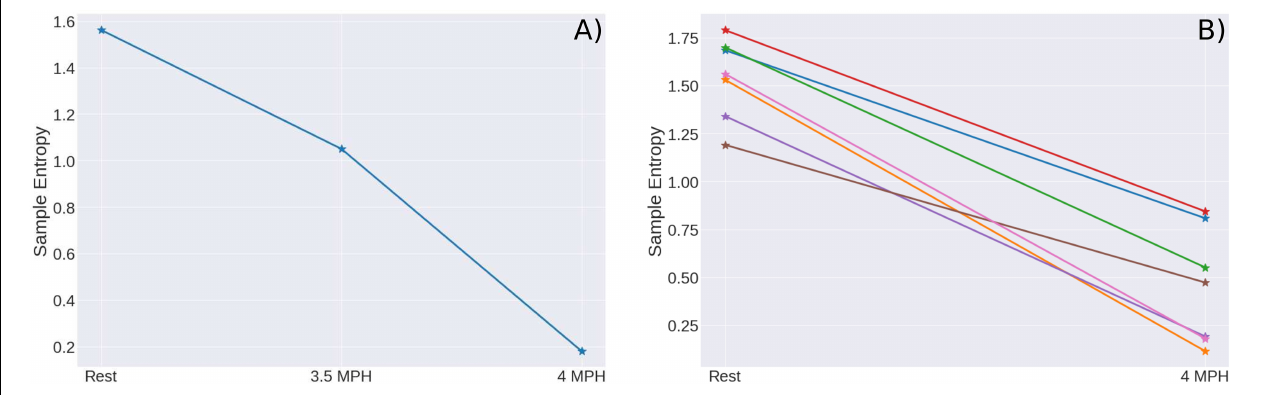
FIGURE 4 | (A) SampEn for one subject where the first record belongs to the rest period, the second record to a cardiac stress condition at 3.5 mph and the third measure to a cardiac stress condition at 4 mph. (B) SampEn values for rest and cardiac stress tests of one subject in seven measures. The mean of SampEn at rest is 1.3541 ± 0.187 and at cardiac stress SampEn mean is 0.4344 ± 0. 2475.